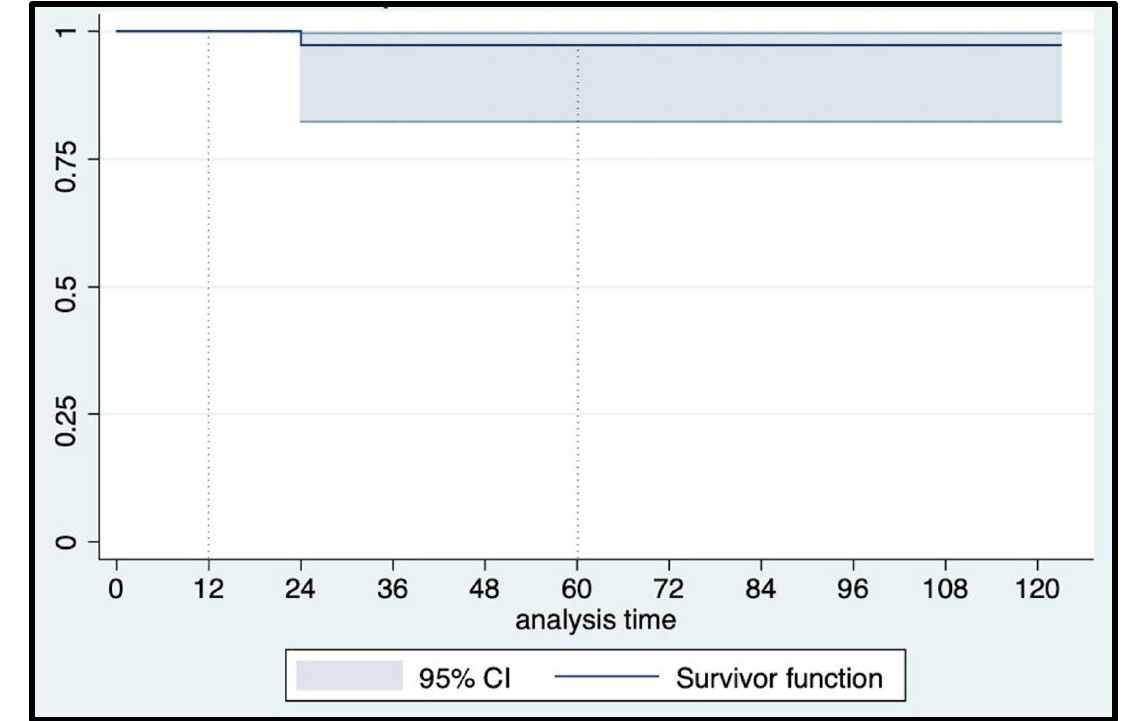
Figure 7. Kaplan–Meier noniatrogenic erosion ‐ free survival curve.